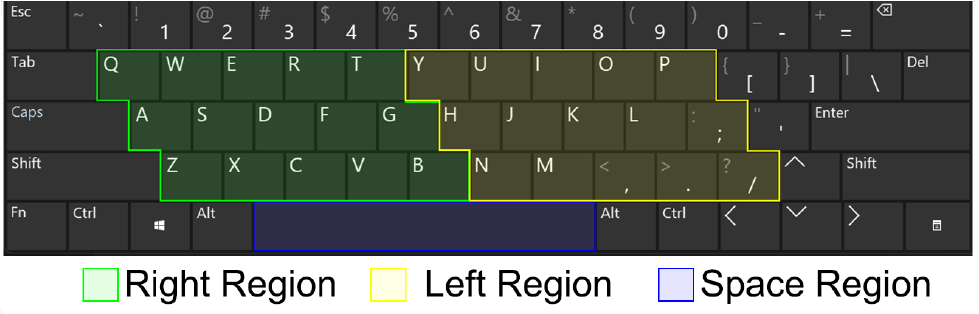
Figure 2. Keyboard collection structure used to build the used experimental dataset.